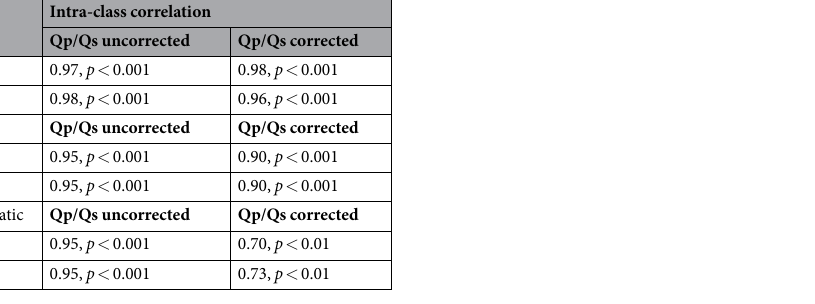
Table 3. Intra- and inter-observer variability.